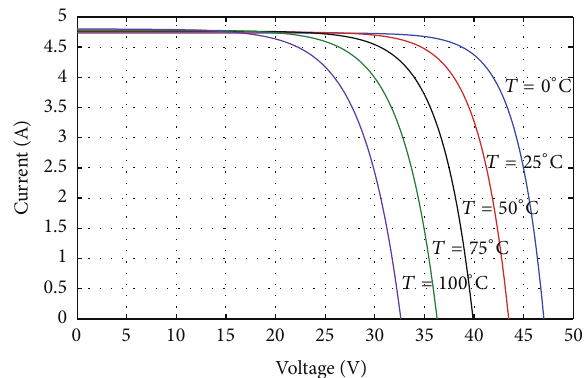
Figure2:PVmodulevoltage-currentatdifferenttemperaturelevels.